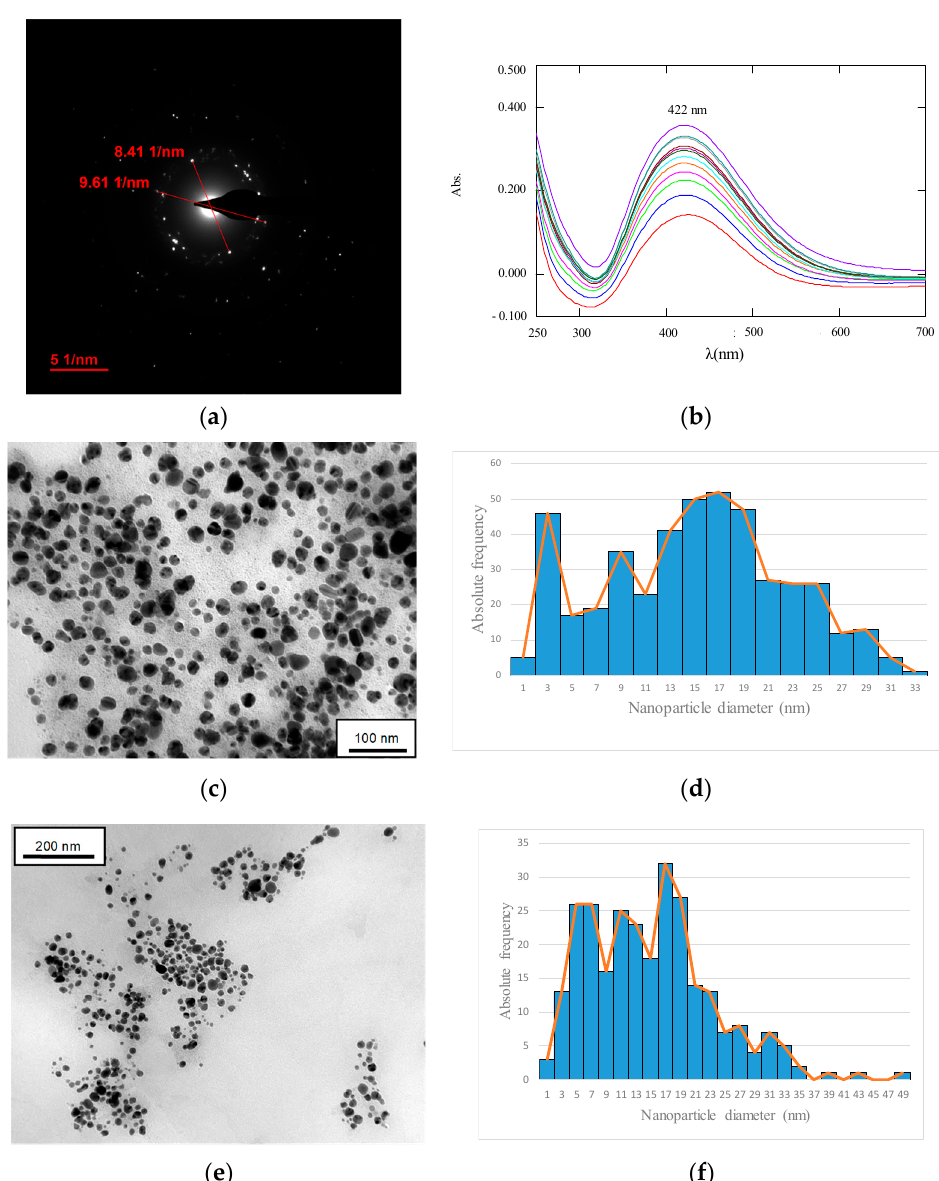
Figure 6. ( a ): Ag-NPs identified by electron diffraction on metallic precipitates in Figure 5e where interplanar lattice distances are shown. ( b ): UV-vis spectra obtained in the Ag-NPs synthesis assay from the cellular extract of Rhodotorula mucilaginosa 1S1 between 24 h (red spectrum) and 312 h (purple spectrum). TEM images of the Ag/AgCl-NPs recovered after biological synthesis from the cell extract of Rhodotorula mucilaginosa 1S1, ( d , f ) represent the histogram and frequency polygon of the size distribution obtained for images ( c , e ), respectively.